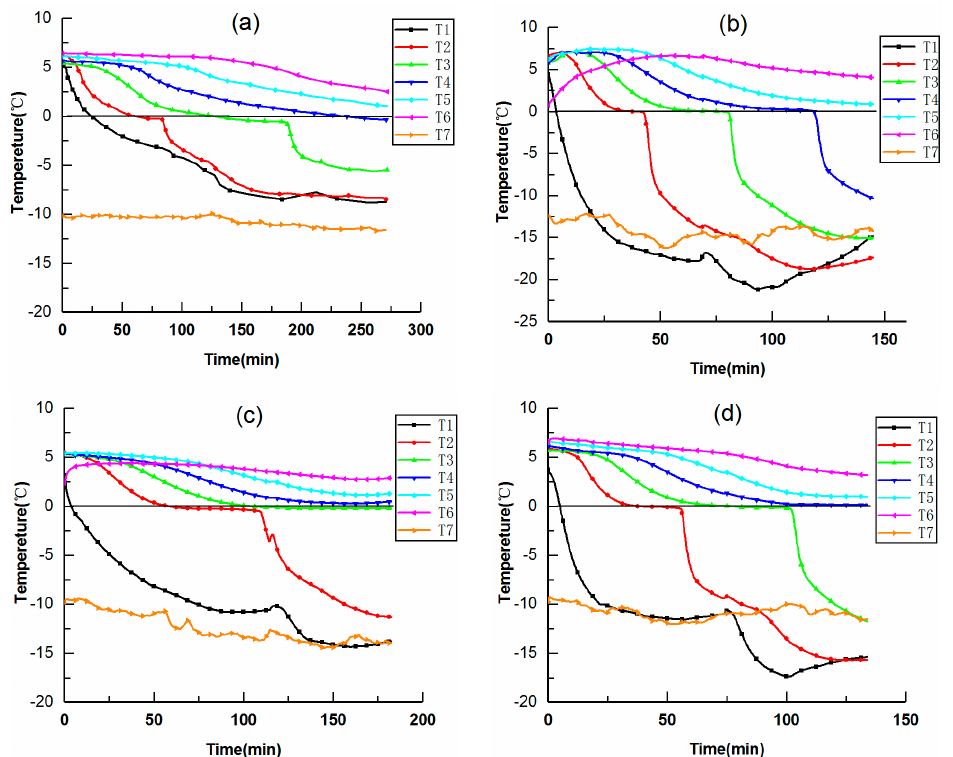
Figure 3. Evolution of the temperature in the freezing model during natural cold gas injection (( a ) Experiment 1, ( b ) Experiment 2, ( c ) Experiment 3, ( d ) Experiment 4; and T7 represents ambient temperature).